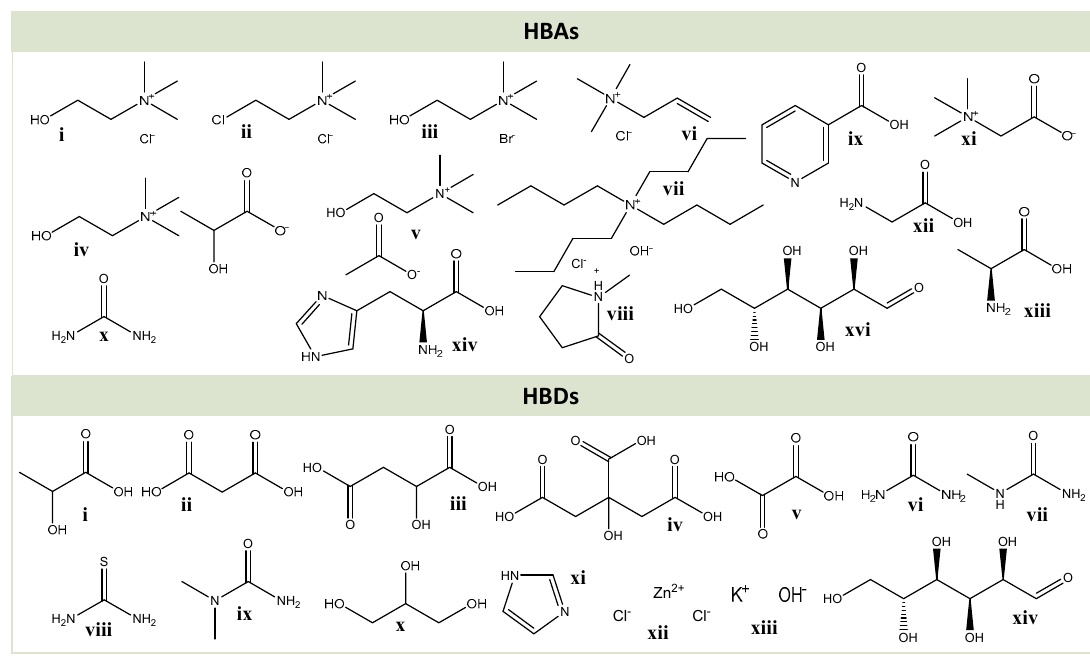
Figure 3. Chemical structures of the DESs’ HBDs and HBAs reviewed in this work.